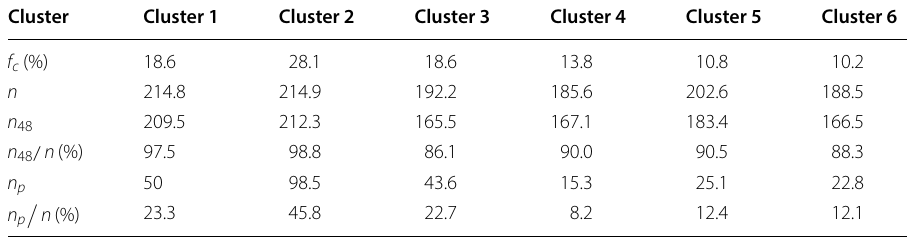
Table 3 Statistics of the clusters from Fig. 3 Cluster Cluster